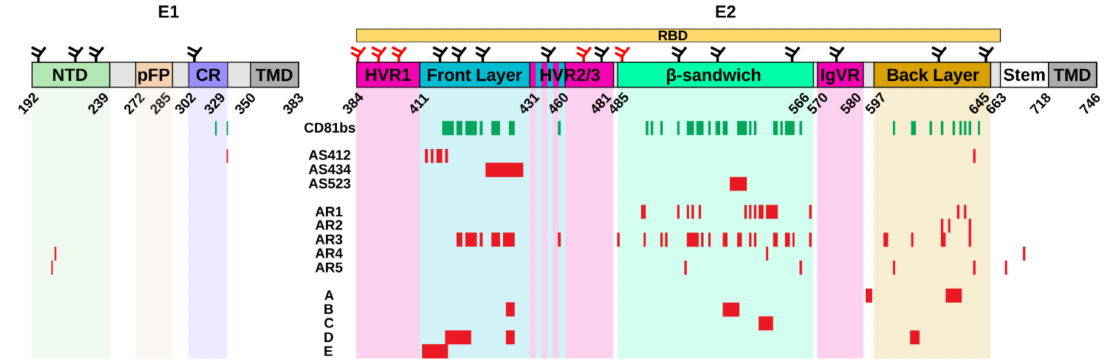
Figure 1. Schematic representation of the primary E1/E2 sequence, including functional regions and epitope clusters. Domain legends not defined in the main text: NTD (N-terminal domain), pFP (putative fusion peptide), CR (conserved region), CD81bs (CD81 binding site). CD81bs and conformational epitopes defined as in Gopal et al. 2017 [47]. Residues comprising each epitope are reported in red, residues involved in the interaction with CD81 in green. N- and O-glycosylation sites are depicted as black and red branched forks,